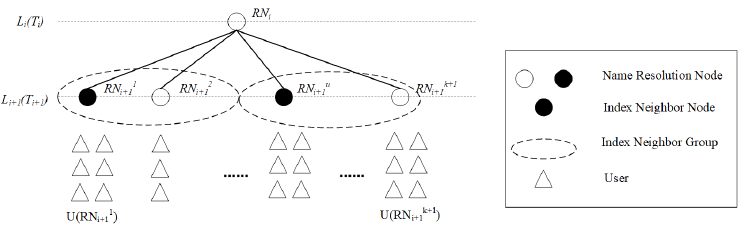
Figure 3. LNMRS model with two levels, with a master node and two index neighbor